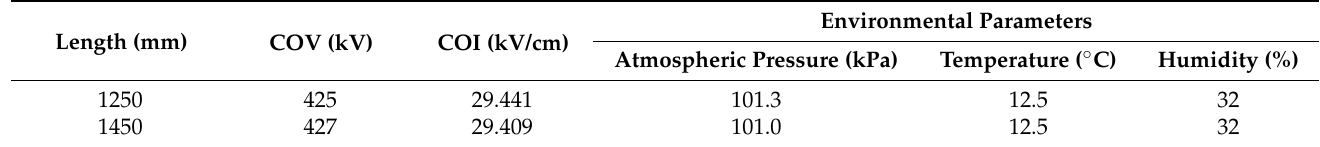
Table 3. COI test results of elliptical grading rings with pipe diameter of 60 mm and ring diameter of 800